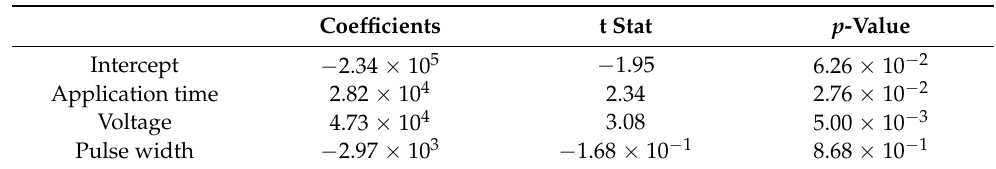
Table 1. Multiple regression analysis between VRE sterilization rates and electrical parameters: part